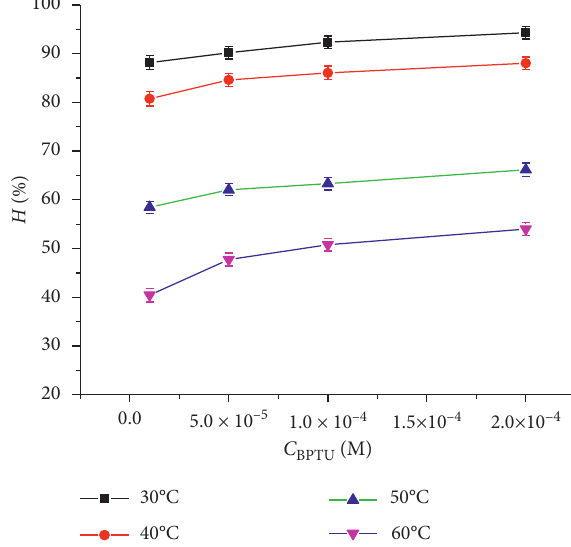
Figure 8: Relationship between concentrations and inhibition efficiencies of BPTU at the different